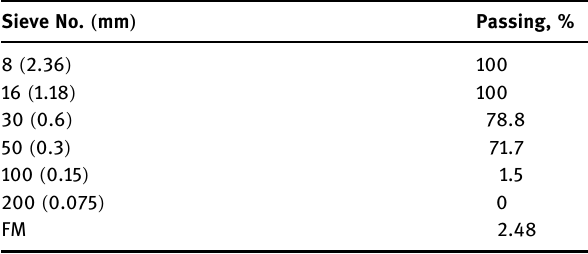
Table 2: Sieve analysis and fi neness modulus ( FM ) of the fi